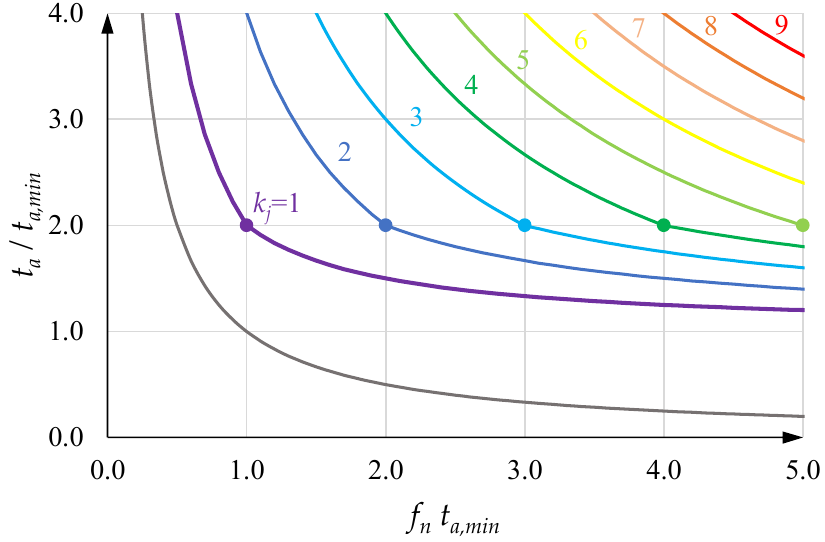
t t versus f t when t is equal to a a,min n a,min j